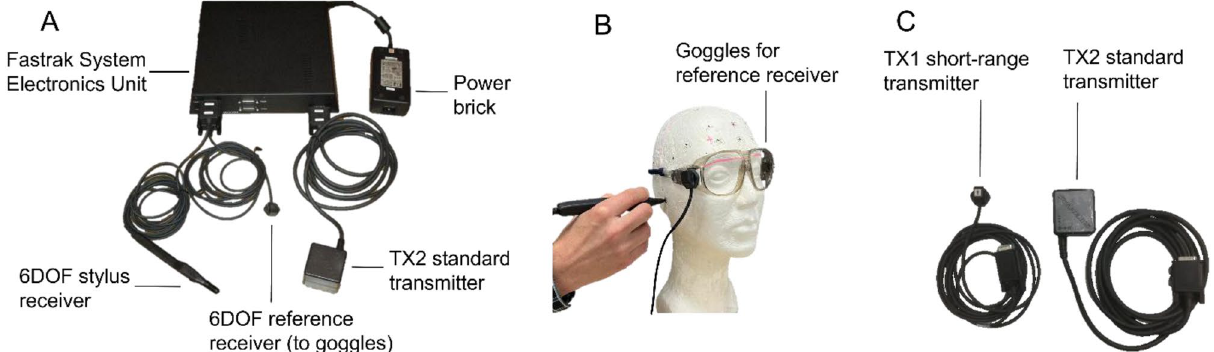
Figure 2. Fastrak system. ( A ) The standard TX2 system components, ( B ) reference receiver attached to googles during digitization, ( C ) physical differences between the TX1 and TX2